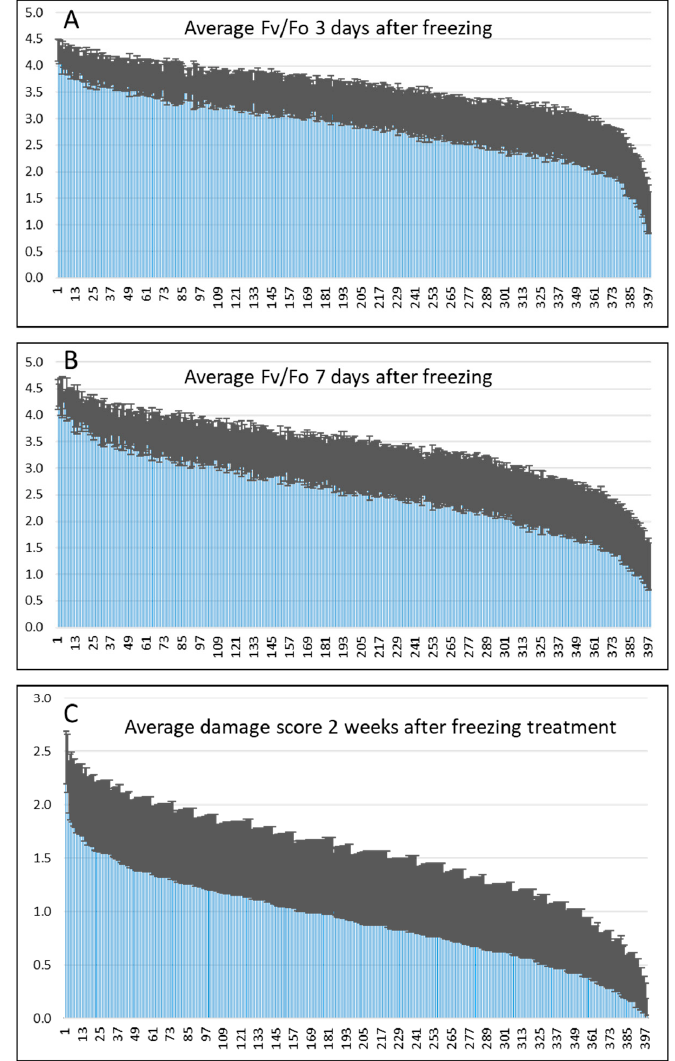
Figure 3. Variation in the winter canola diversity panel (399 plants) regarding freezing survival after acclimation for 2 months at 5 °C. ( A , B ). The value for each accession is the average chlorophyll fluorescence (Fv/Fo) of six separate experiments (18 plants total) 3 day ( A ) and 7 day ( B ) after freezing treatment. ( C ) The value of each plant is the average damage score of six separate experiments (18 plants total) 2-weeks after freezing treatment. Vertical bars indicate standard error.